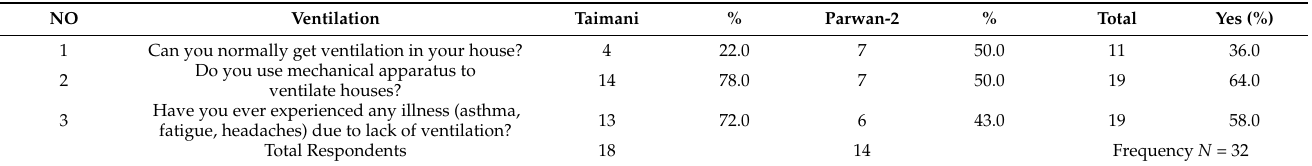
Figure 7. Field survey photography: ( a ) Parwan-2; ( b ) Taimani.